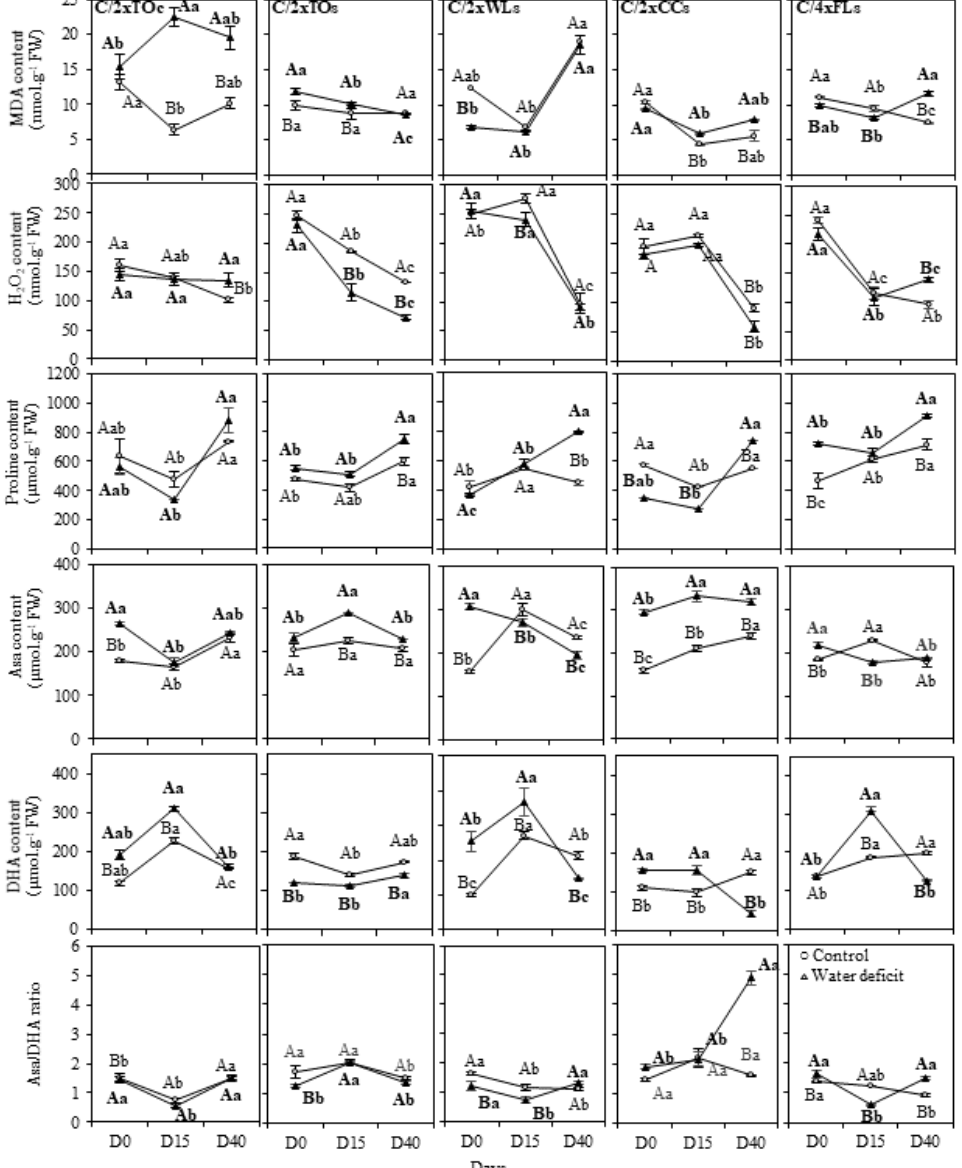
Figure 3. Influence of water deficit on malondialdehyde (MDA), hydrogen peroxide (H 2 O 2 ), proline, reduced ascorbate (Asa), oxidized ascorbate (DHA) concentration and redox status (Asa / DHA) of clementine trees grafted onto di ff erent rootstocks. The tested diploid rootstocks grafted with common clementine were trifoliate orange cutting (C / 2xTOc), trifoliate orange seedling (C / 2xTOs), Carrizo citrange (C / 2xCCs) and Willowleaf mandarin (C / 2xWLs) and FlhorAG1, an allotetraploid somatic hybrid (C / 4xFLs). The white circles and the black triangles correspond to the values